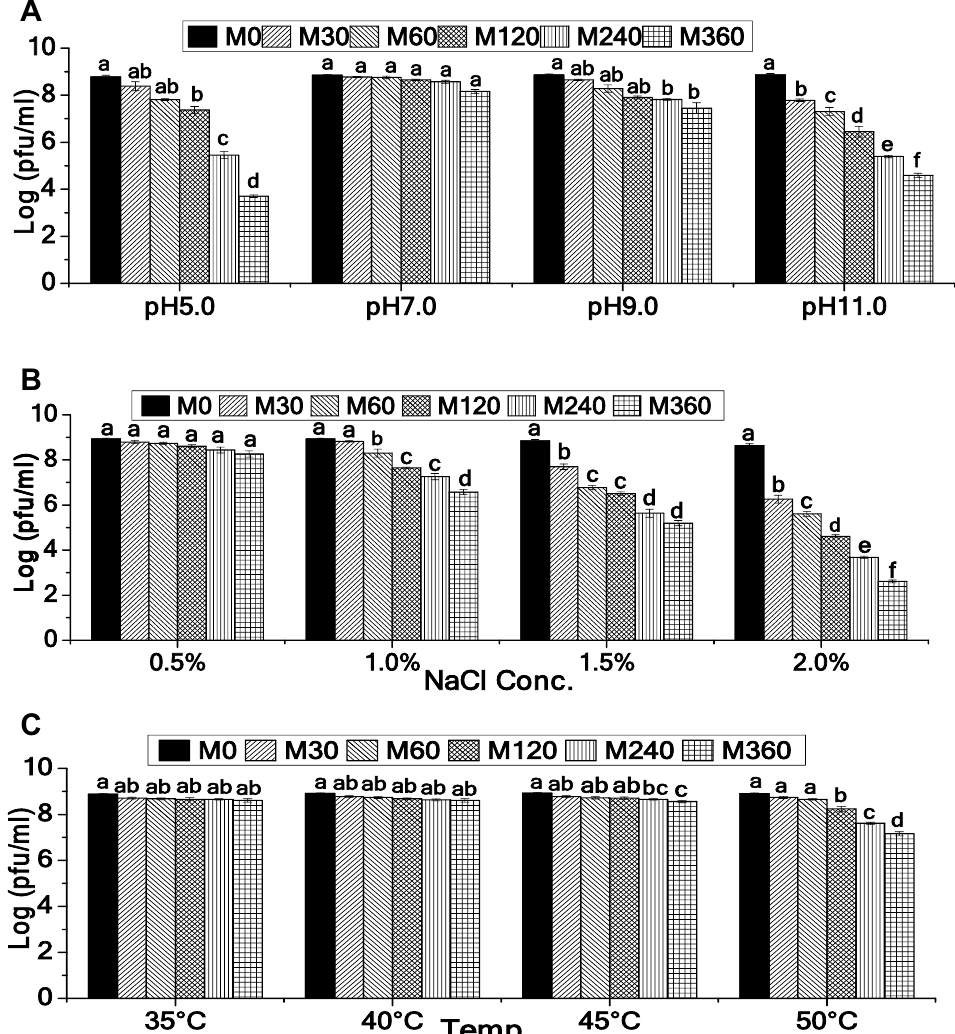
Figure 3. Stability of Shigella virus 2019SD1 under ( A ) Varying acidity and alkalinity levels, ( B ) Varying salinity (NaCl) concentrations and ( C ) Varying temperature regimes. Error bars represent SEM (n = 3). Values of a given phage depicted as column without common letter differ significantly at p ≤ 0.05 as per the Tukey’s HSD